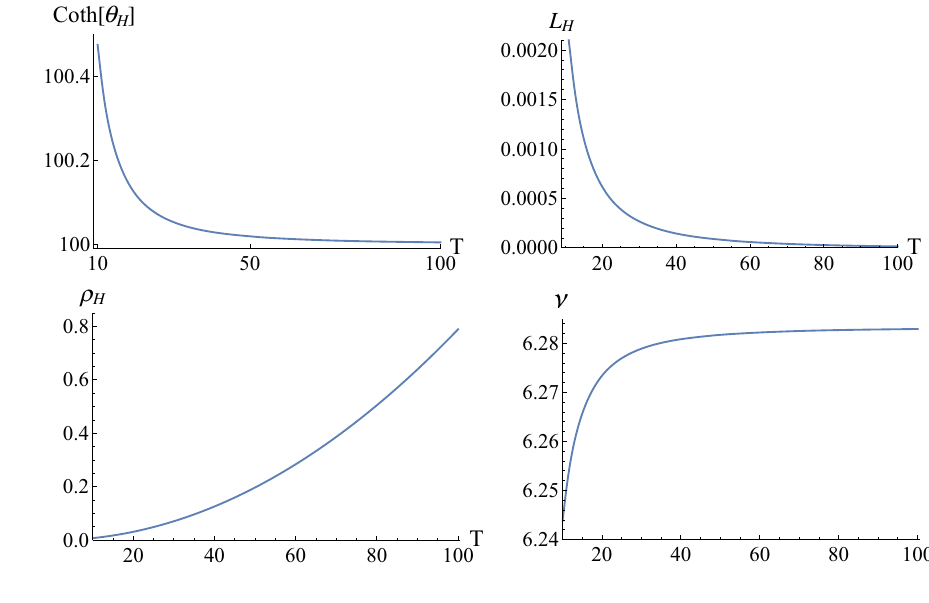
Fig. 2 The transports as the function of temperature T in the high temperature region. Here we have set k = 1, q = 10